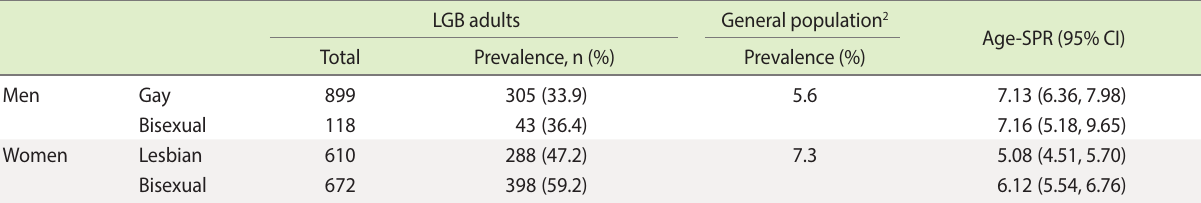
Table 4. SPR of depressive symptoms 1 between LGB population (2016) and the general population (2015) 2 in Korea (N=2,299) LGB adults